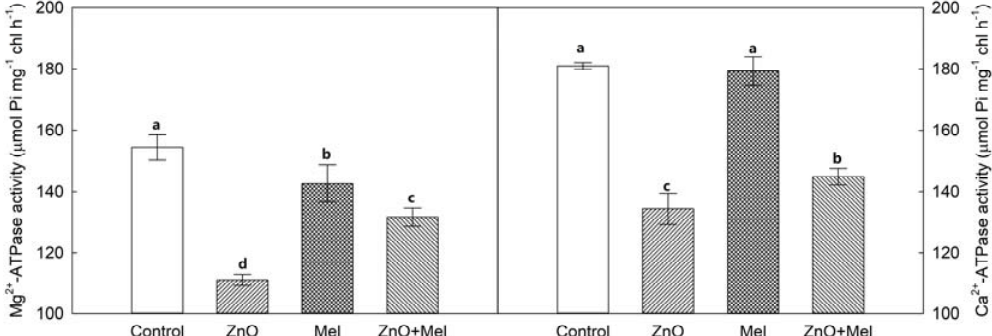
Figure 6. Activities of Mg 2+ ‐ ATPase and Ca 2+ ‐ ATPase in chloroplasts in the last fully expanded leaf in wheat as affected by melatonin application and Zinc Oxide (ZnO) nanoparticles. Mel, melatonin. Data represent the mean ± SE of three replicates. Different letters indicate significant differences ( p < 0.05).